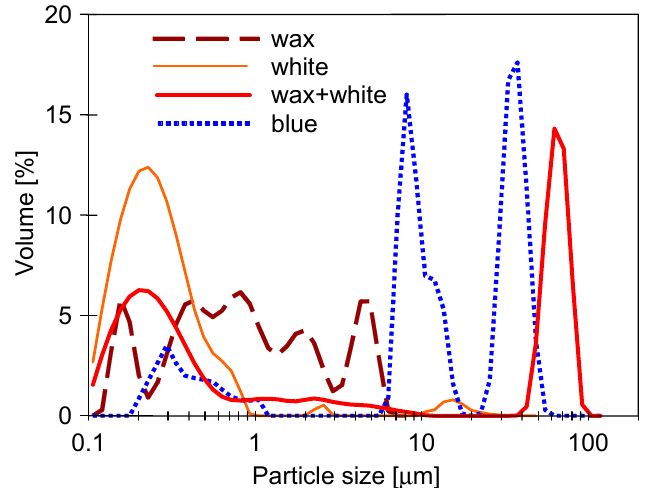
Figure 3. Distribution of particle size in cleaning agents solutions.